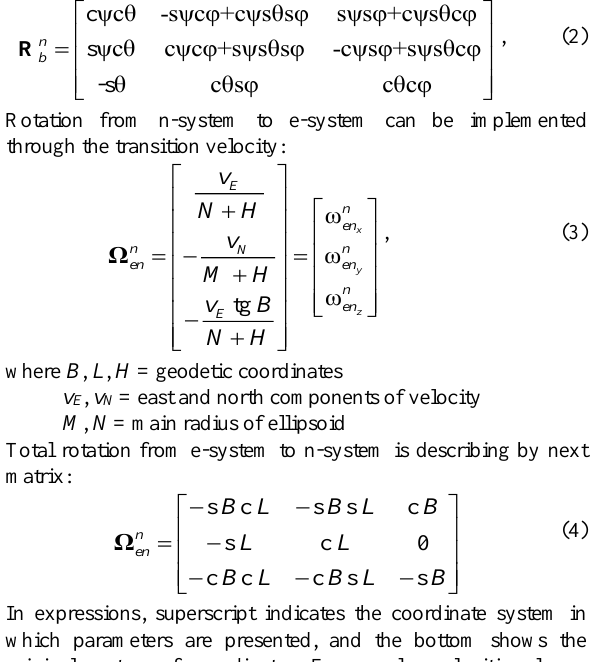
index indicates in respect of which two coordinate systems occurs rotation.